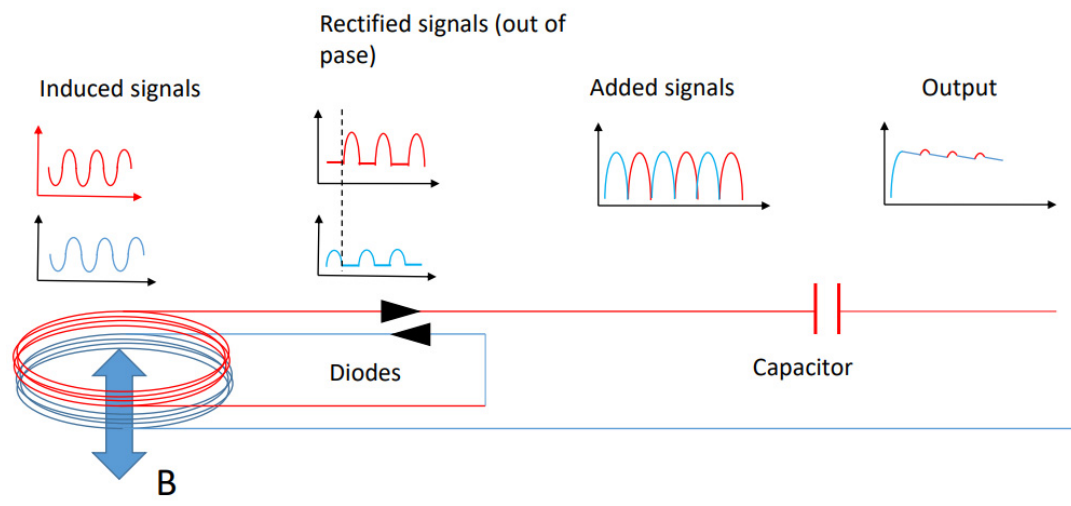
Figure 13. Damping rectifier